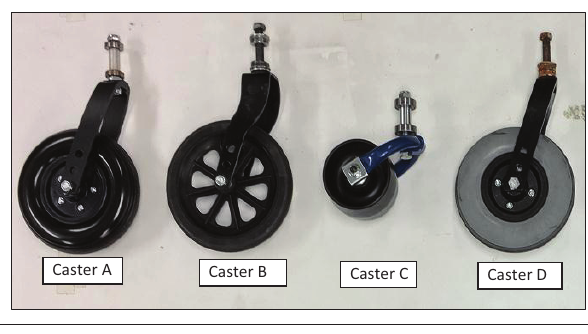
FIGURE 13: Caster assemblies tested in initial testing